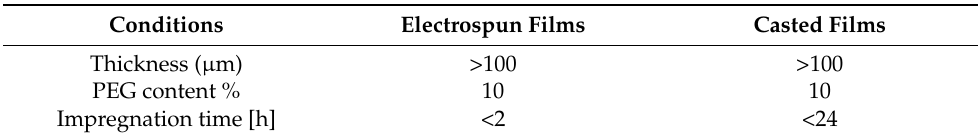
Table 5. Summary of the optimized set condition for both electrospun and casted PCL films to be impregnated with scCO 2.